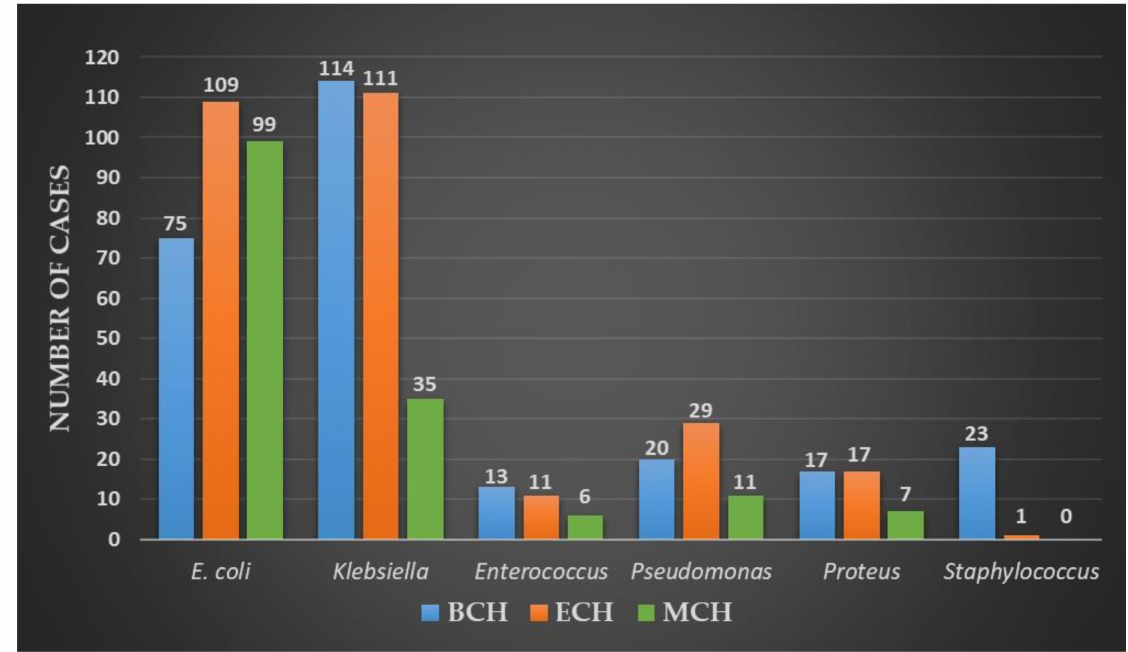
Figure 1. Distribution of the MDR uropathogens in the study centers. Except for BCH center, where Klebsiella spp. (43.51%) surpassed E. coli (28.62%) in prevalence, the rest of the Gram-negative uropathogens respected the distribution in all subjects. Overall, Enterococcus spp. was the most incriminated Gram-positive bacterial strain, except for the BCH center, where Staphylococcus spp. surpassed it in prevalence; in the EUH center, a single strain of MDR- Staphylococcus spp. was detected; as for the MCH center, none of these pathogens were registered. In terms of age-group distribution, both males and females showed an increased prevalence at the lower pole of the distribution axis with 6.45% females and 6.68% males in their 18–29 years. We noted a progressive increase in MDR-UTIs with every decade of life. This highlights the correlation between age and incidence of UTIs; a high quota was observed in seniors between 60–69, representing 24.73% in females and 30.07% in males, with a peak of incidence in patients over 70 years old—48.28% in the overall population. Detailed data on age-group distribution is displayed in Table